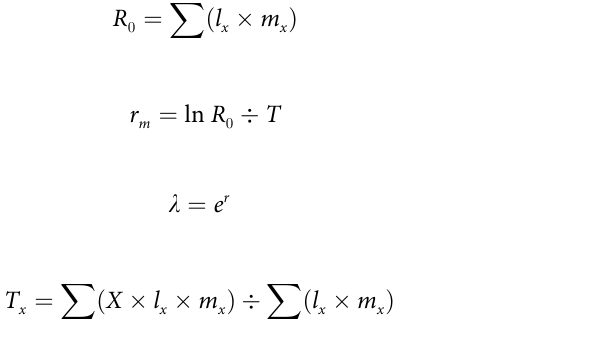
2.3.3 Fertility table establishment. Based on data from the time-specific life tables, spe- cific indicators for the fertility tables and their data processing are as follows. We defined X as the age of a sample in years, l as the proportion of plants surviving at the start of age interval x as the average number of progeny produced by individuals in X-age, R x , m x ductive rate, r as the intrinsic rate of increase, λ as the increment rate per unit, and T m average period from the birth of parents to the birth of progeny.